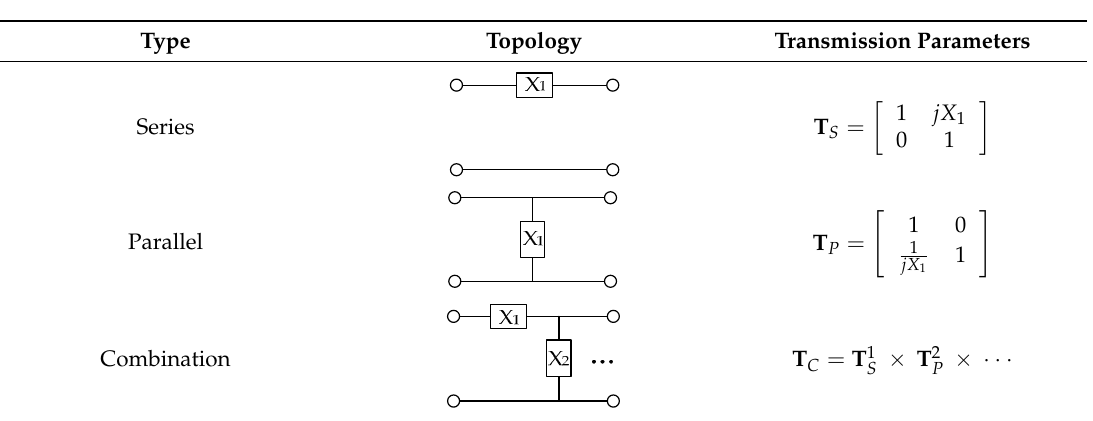
Table 1. Some commonly used tuning and impedance matching circuits.